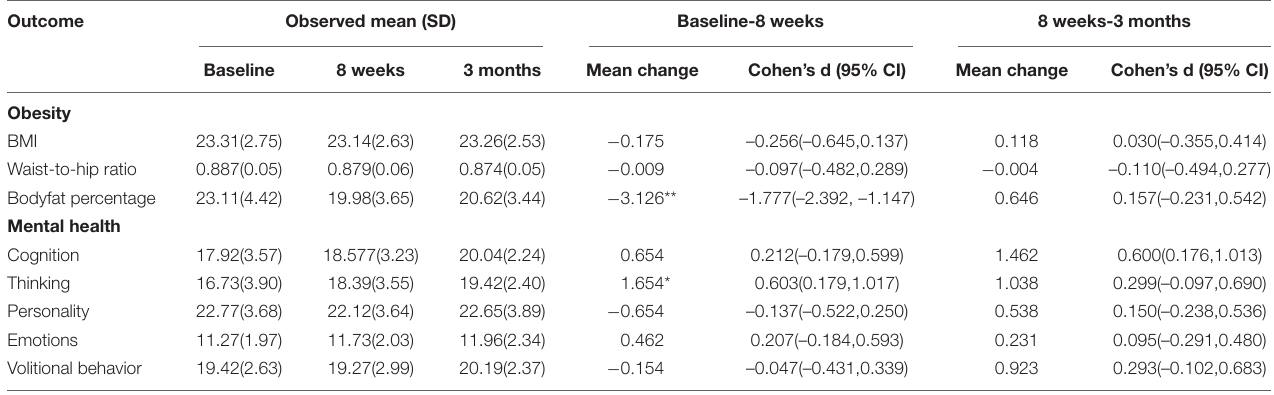
TABLE 2 | Baseline, 8 weeks and 3 months obesity and mental health variable descriptive statistics.